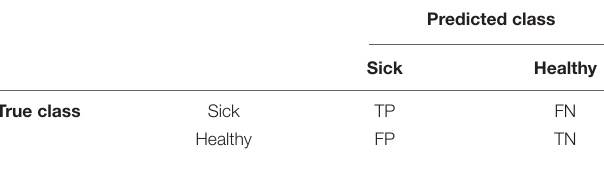
TABLE 2 | Confusion matrix for a two-class classification problem, where the number in the i -th row and j -th column is C ij . True class Sick